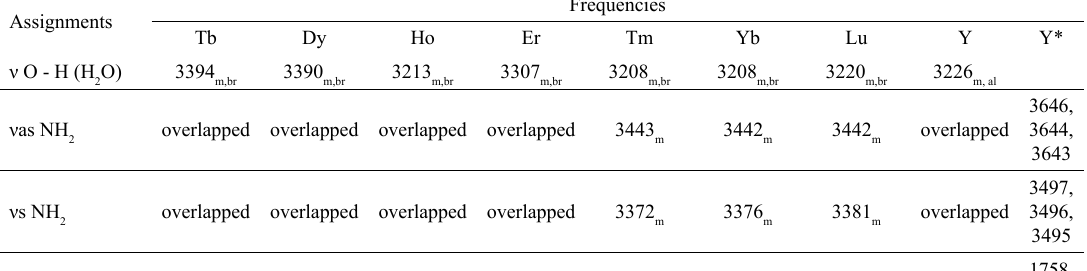
Table 3. Main vibrational frequencies in infrared of the oxamate complexes of lanthanides and yttrium.